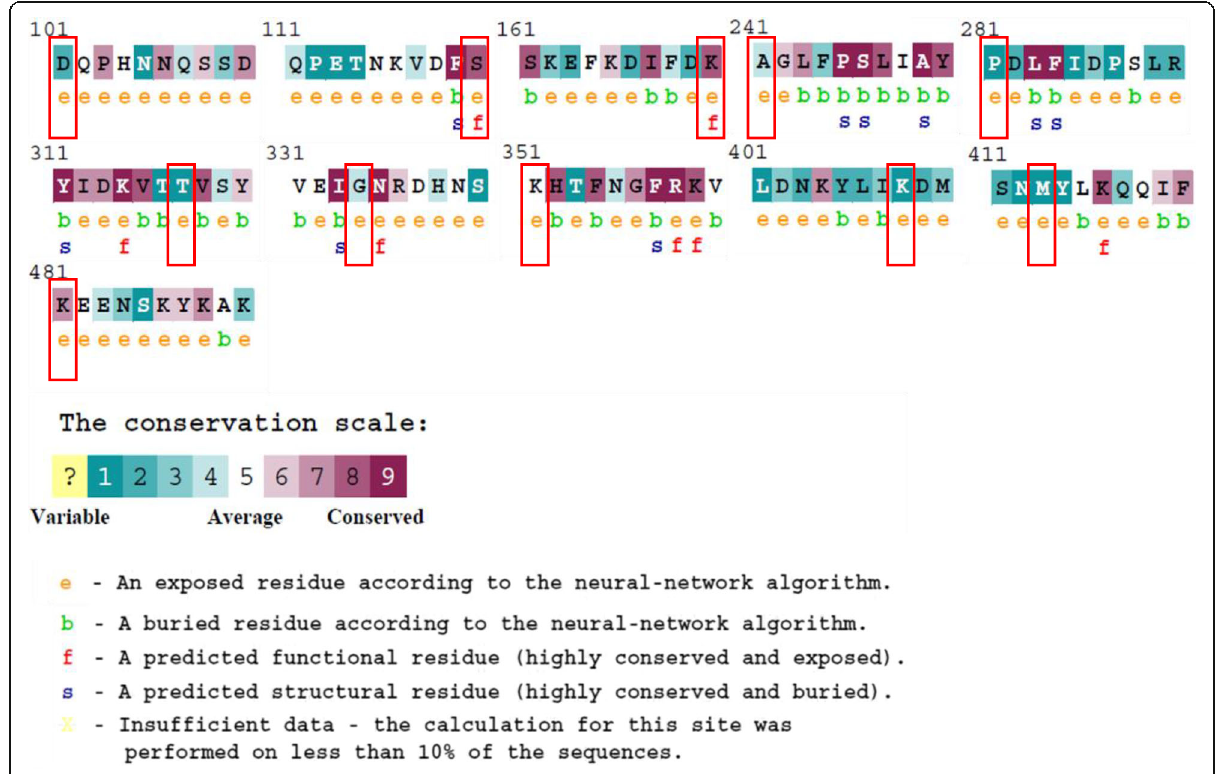
Fig. 3 Consurf profile of LppA protein of Mcc ATCC 27234. The red rectangle marks the position value of amino acids of interest